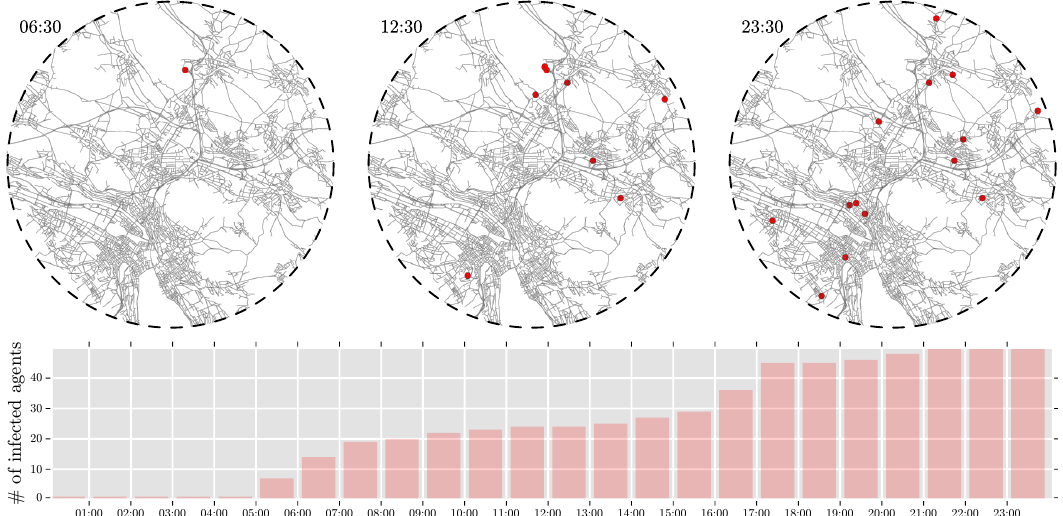
Figure 6. Temporal-spatial epidemic spread. Red dots indicate infected